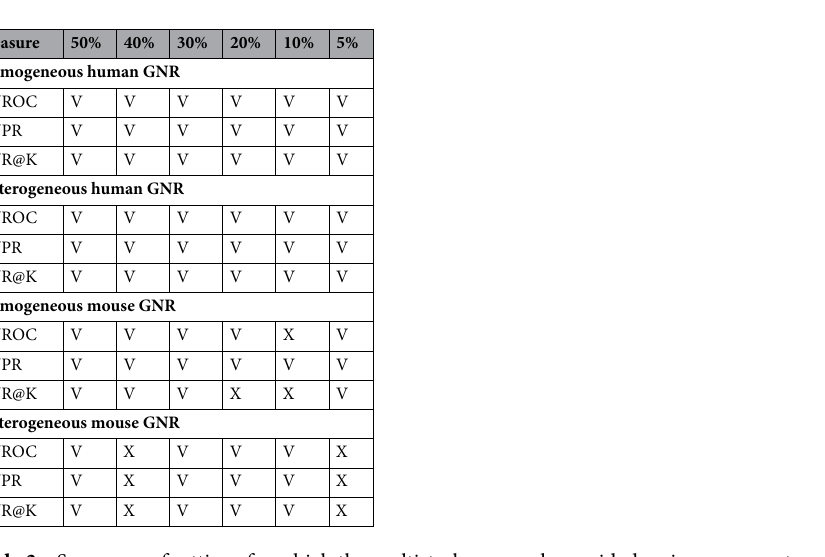
Table 3. Summary of settings for which the multi-task approach provided an improvement over the